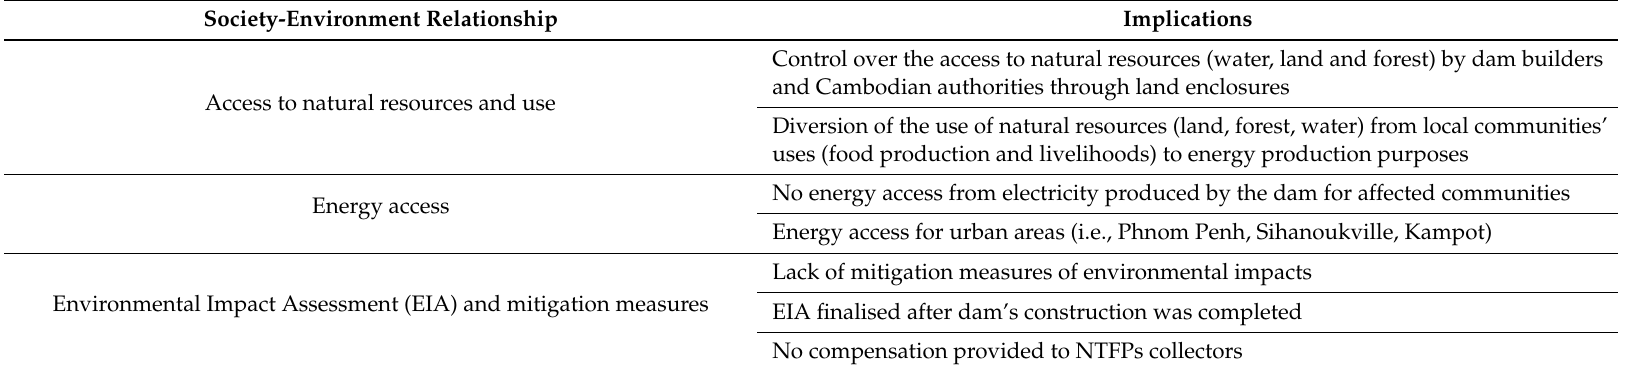
Table 6. Changes of society-environment relationships associated with the Kamchay dam construction.